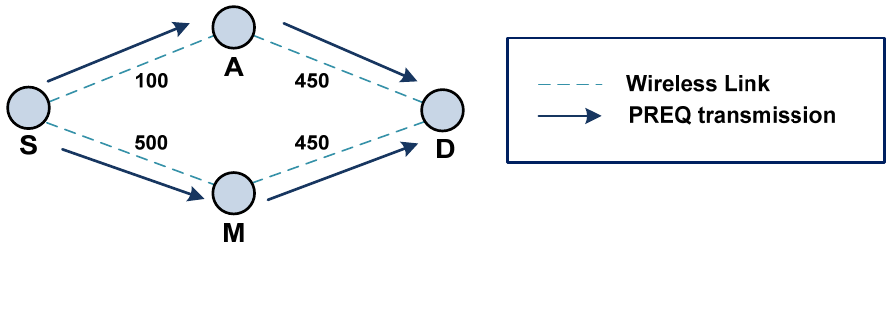
Figure 8. Example of a path diversion